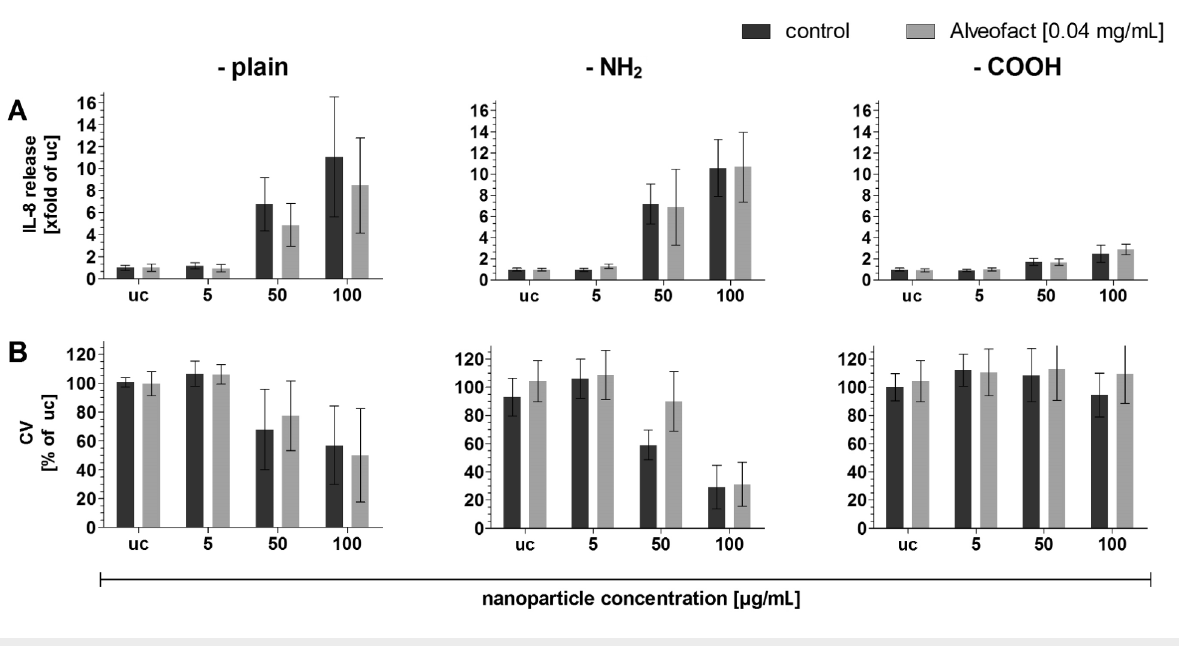
Figure 4: Comparison of inflammatory responses of A549 after stimulation with different aSNPs (–plain, –NH 2 , –COOH; 5–100 µg/mL, uc: untreated control) in combination with (light grey columns) and without (dark grey columns) lung surfactant (Alveofact, 0.04 mg/mL). Alveofact and aSNPs were simultaniously stimulated for 4 h and cells were then cultivated for a further 20 h period in fresh cell culture medium (4 h/20 h). A: IL-8 release after 4 h/20 h stimulation; B: cell viability (crystal violet, cell loss measurement) correlated to IL-8 (after 4 h/20 h). Data are depicted as means ± S.D. of 3 independent experiments with n = 3. For statistical analysis two-way ANOVA with Bonferroni’s post test was conducted. * P < 0.05, ** P < 0.01 and *** P < 0.001 compared to the untreated control.